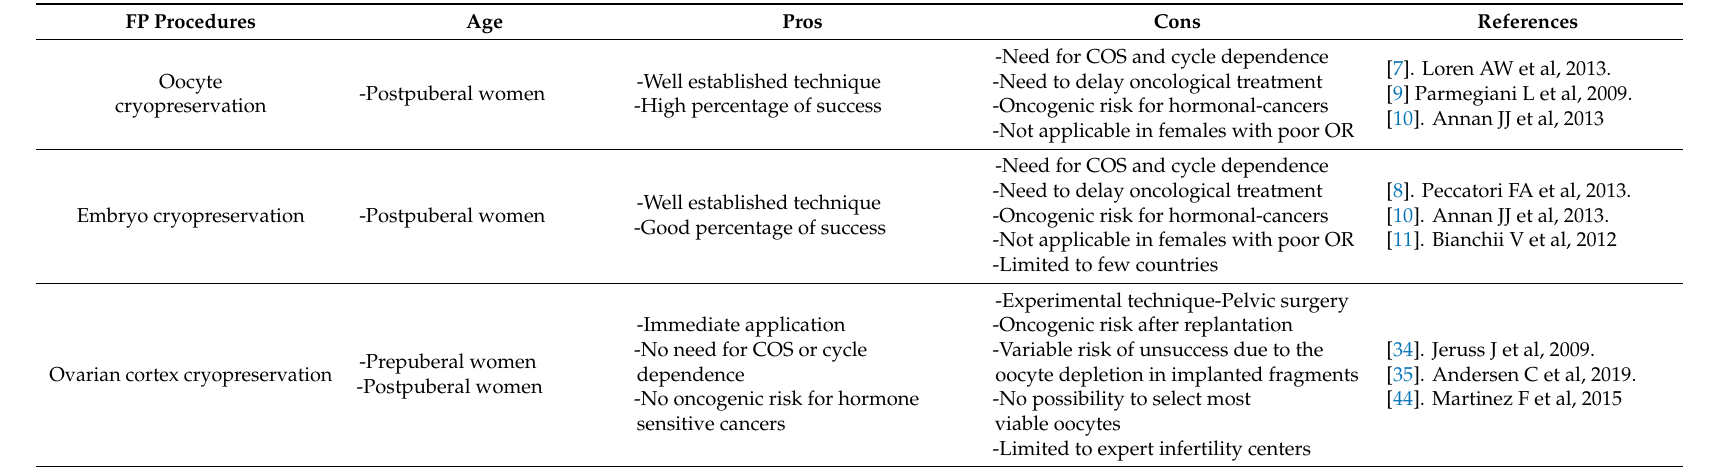
Table 1. Schematic description of advantages and disadvantages of the major procedures adopted for fertility preservation (COS: Controlled ovarian hyperstimulation, OR: ovarian